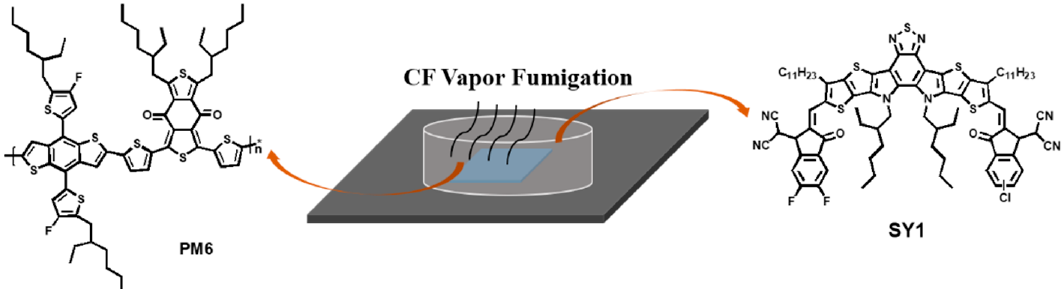
Figure 1. Schematic diagram of CF SVA-treated film based on PM6 and SY1.